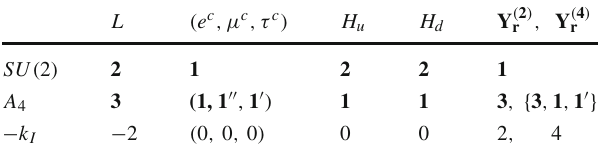
Table 4 Assignments of representations and weights − k I for MSSM fields and modular forms of weight 2 and